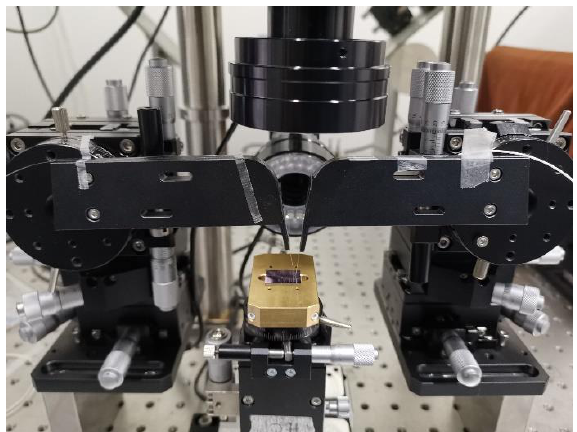
Figure 9. Experimental test system with vertical grating couplers.